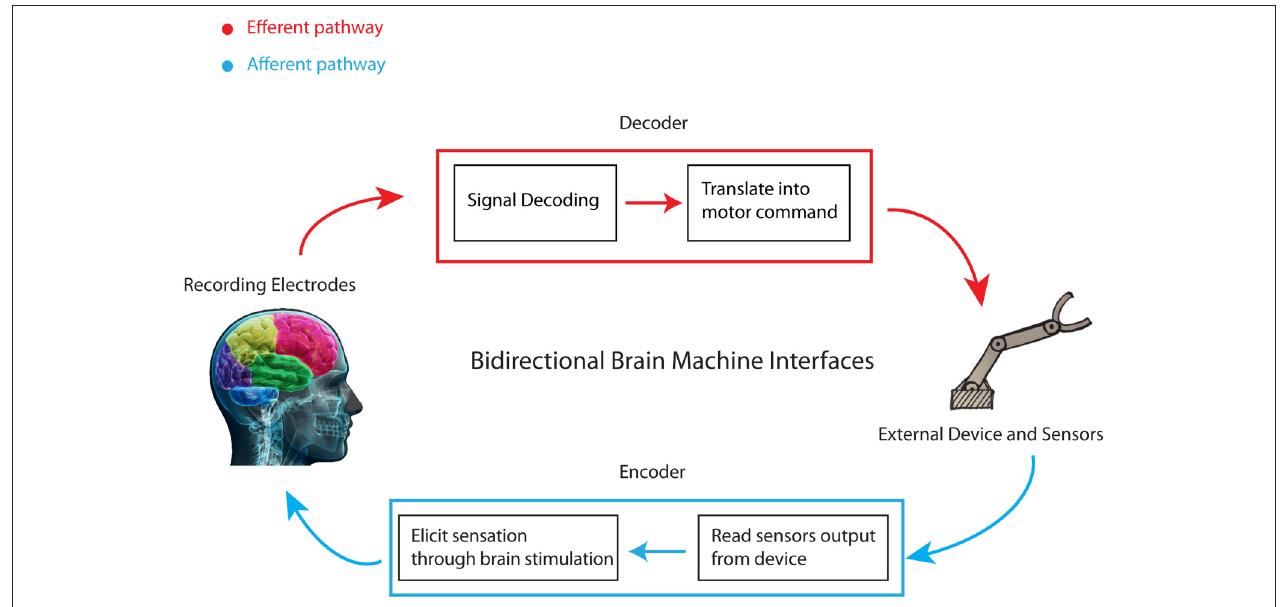
FIGURE 1 | Schematic of a bidirectional brain-machine interface. A bidirectional BMI has two pathways of communication with the brain: an afferent pathway from some sensors to the brain and an efferent pathway from the brain to a device controlled by it. The decoder—or motor interface—transforms the recorded activity into motor commands for the device. The encoder—or sensory interface—transmits the information about the external world or about the state of the device to the brain by delivering electrical stimulation patterns to